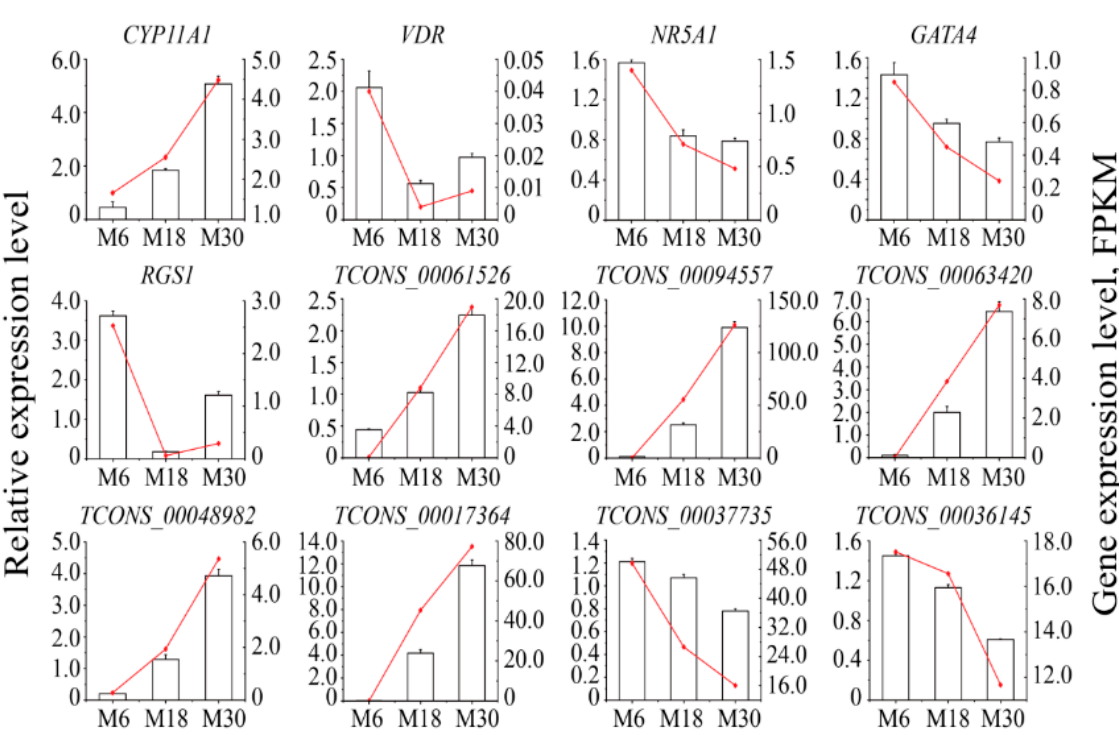
Figure 7. Validation of the expression of differentially expressed genes by qRT-PCR. Data from the qRT-PCR are shown as columns and on the Y -axis on the left, while the data from RNA-Seq are shown as lines and on the Y -axis on the right.